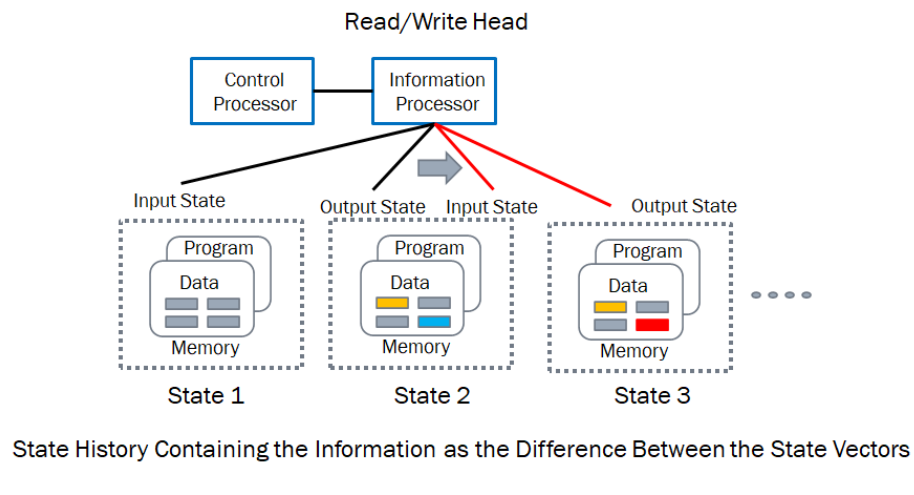
Figure 6. Data and the program stored in the computer memory are processed by the CPU in the information processor.